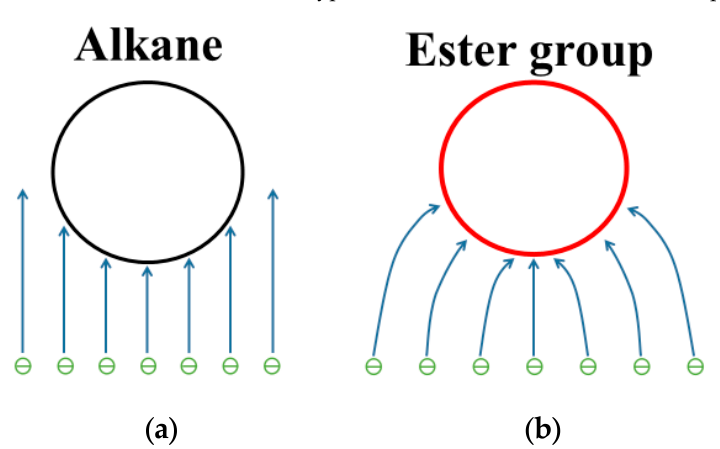
Figure 11. Sketch of the impact ionization in insulation oil: ( a ) MO; ( b ) ester insulation oil.